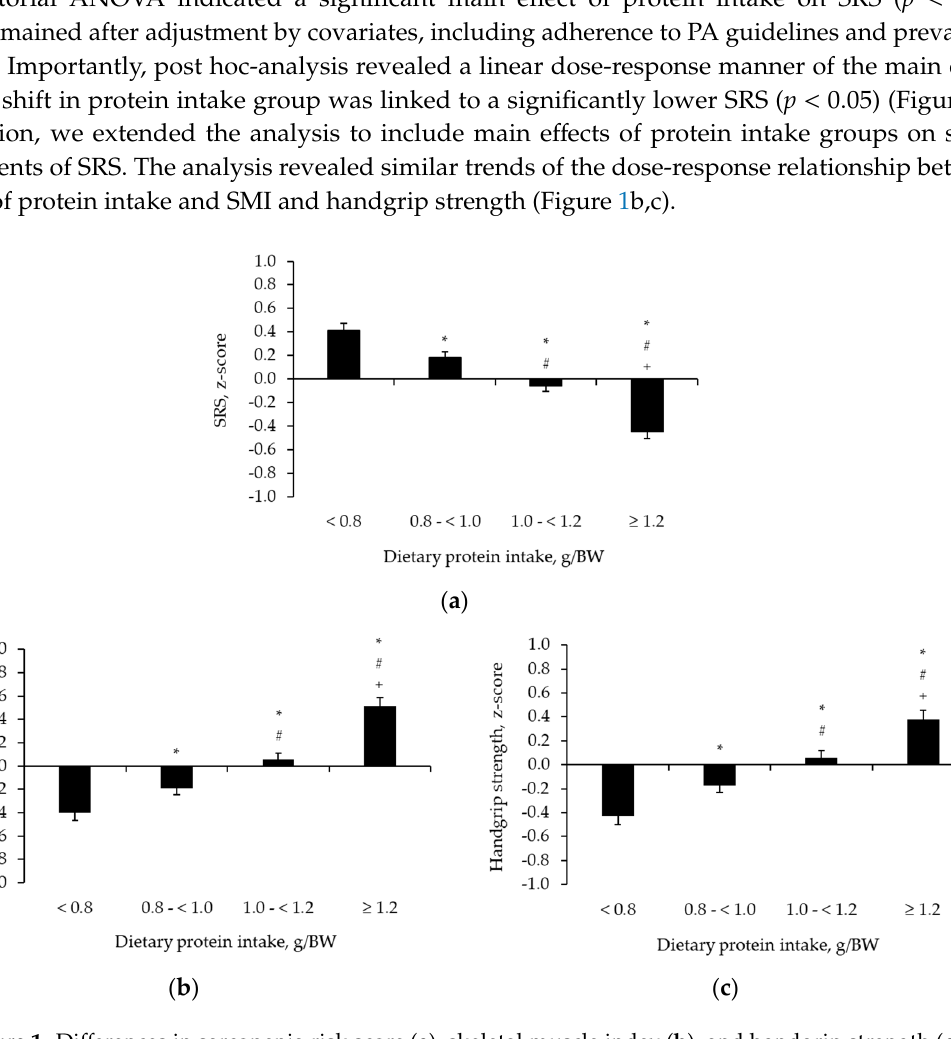
Figure 1. Differences in sarcopenia risk score ( a ), skeletal muscle index ( b ), and handgrip strength ( c ) across groups of protein intake. Data are estimated marginal means ± SEM adjusted for age, recruiting centre, medication, smoking habits, prevalence of MetS, adherence to PA guidelines, fibre intake, and total energy intake. * p < 0.05 vs. < 0.8 g/BW protein intake; # p < 0.05 vs. 0.8–<1.0 g/BW protein intake; and + p < 0.05 vs. 1.0–<1.2 g/BW protein intake.